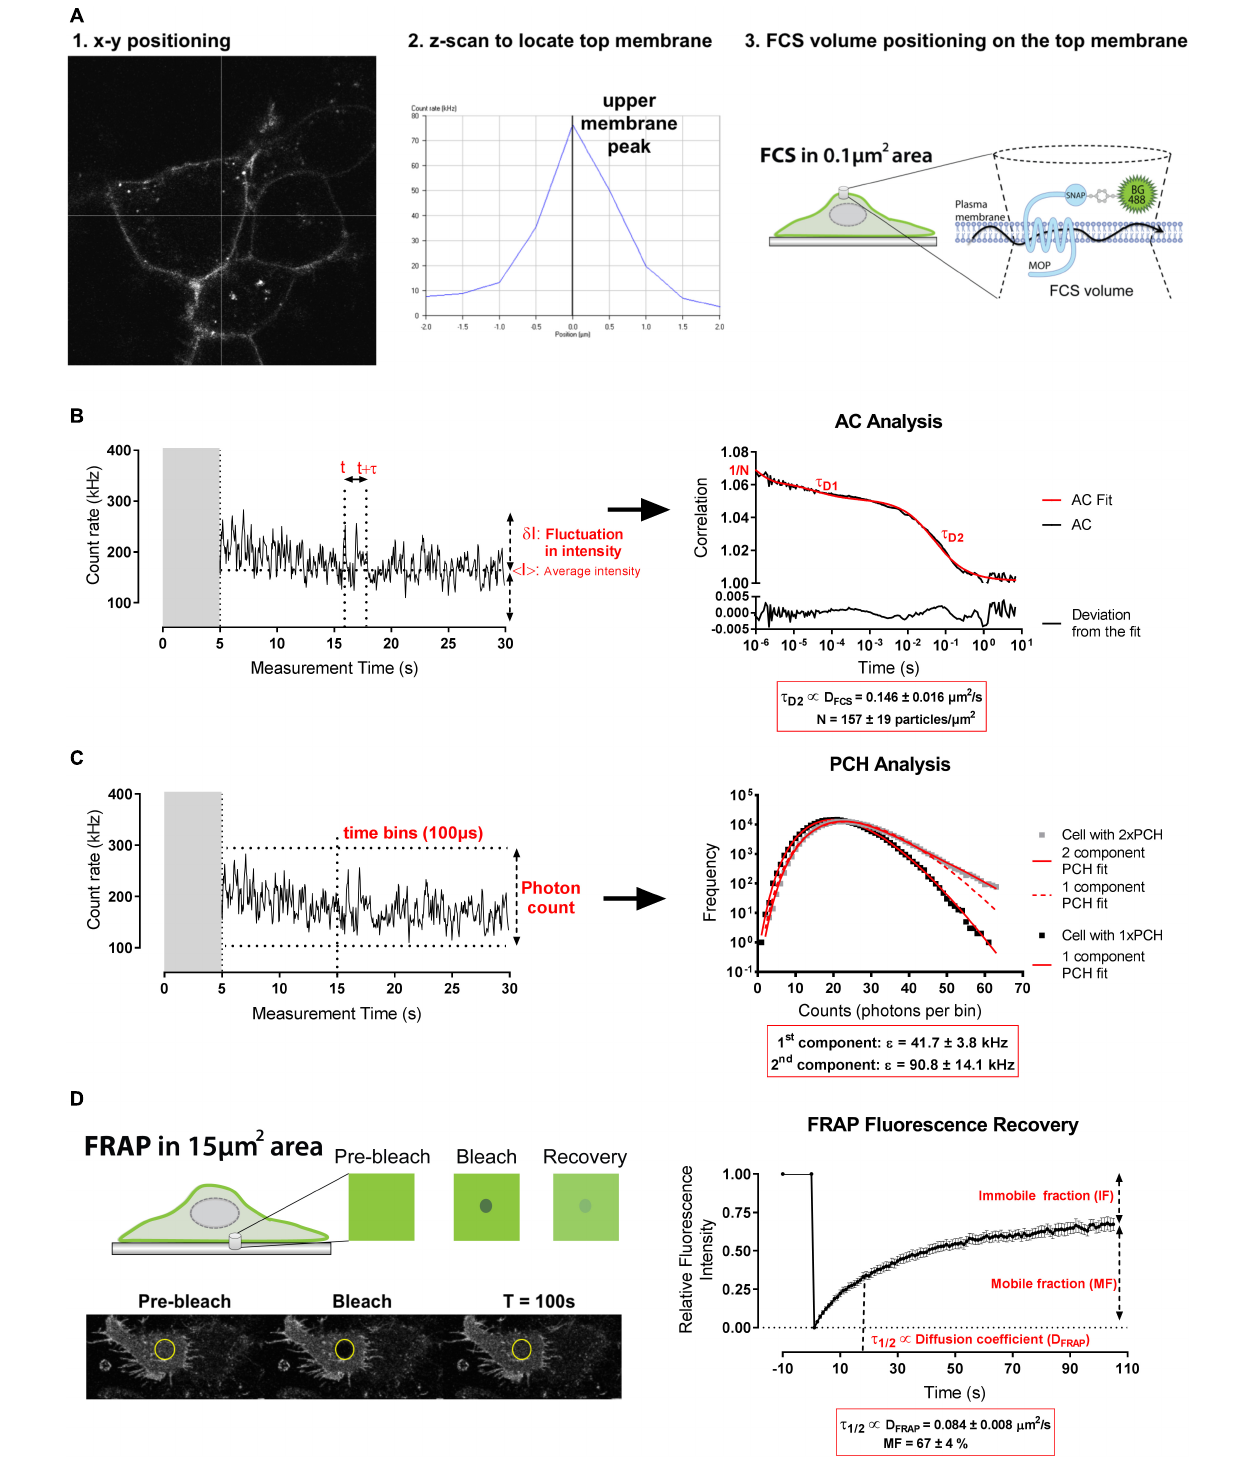
FIGURE 1 | Basal plasma membrane organization of MOP detected by FCS and FRAP. (A) FCS measurement volume was positioned on the upper membrane using a live confocal image (1) and an intensity scan in z (2). (3) Schematic representation of FCS measurements on the membrane of HEK293 SNAP-MOP cells labeled with SNAP-Surface 488 (BG-488) dye. (B) Representative fluctuation trace in basal conditions for autocorrelation (AC) analysis in which fluctuations in intensity ( δ I) from the intensity mean ( < I > ) are calculated at two time points (t and t+ τ ) for all t and a range of τ values to generate an AC function that provides